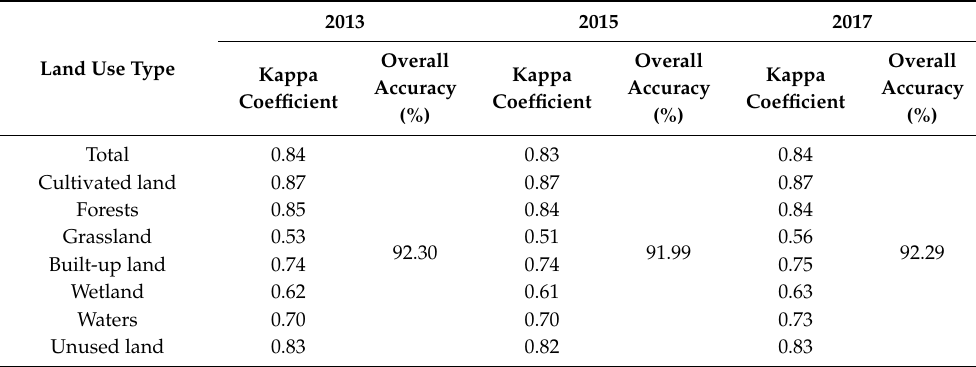
Land Use Type Land Use